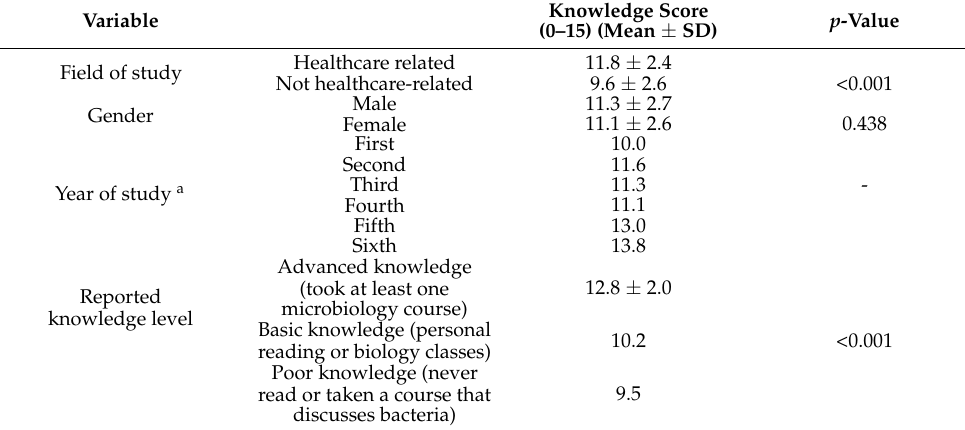
Table 3. Knowledge scores among different